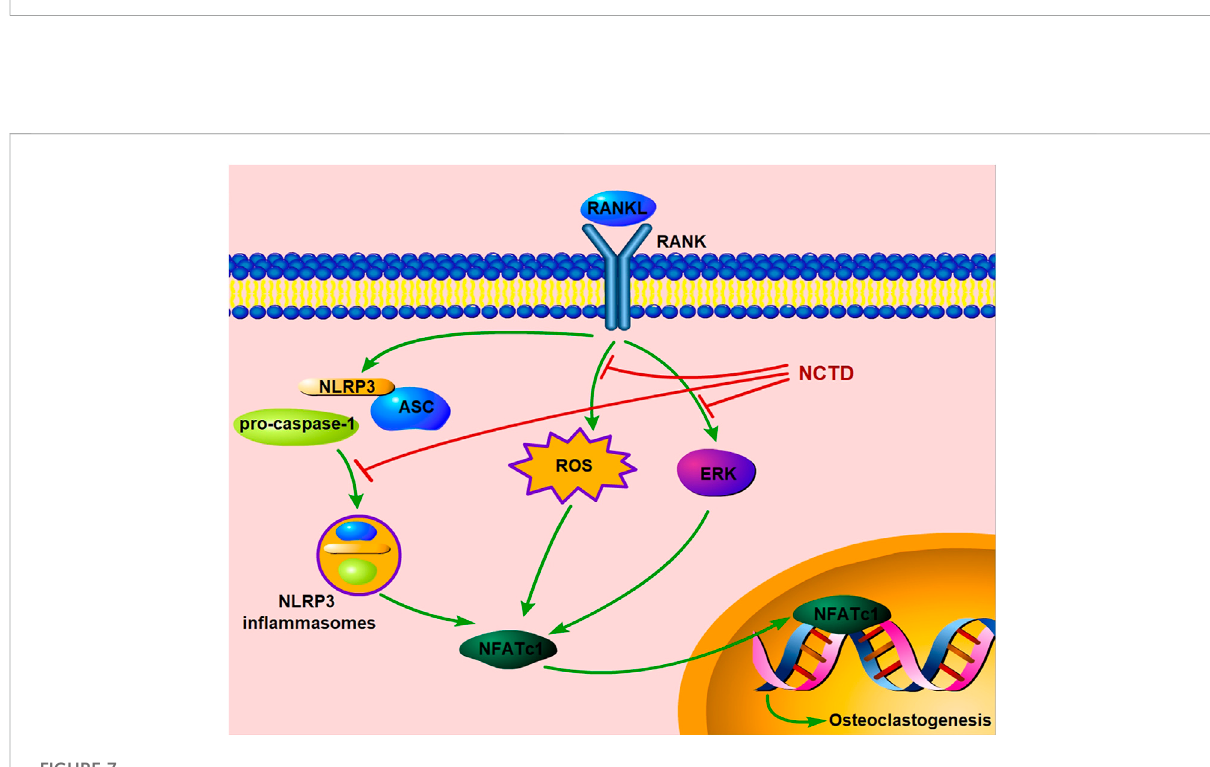
Schematic diagram indicates the potential protective effect of NCTD on